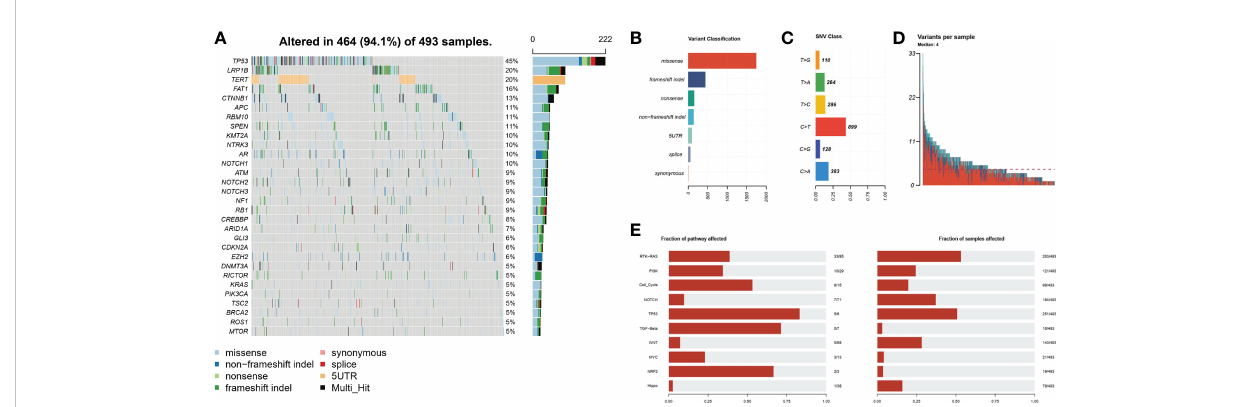
FIGURE 1 Mutational landscape by ctDNA pro fi ling in the Chinese HCC cohort. (A) The ratio of the top 30 genes in the number of mutations. (B) Frequency of different mutation classi fi cations. (C) Frequency of SNV class. (D) Variant number per HCC samples. (E) The number of mutated genes contained in the number of mutated samples per pathway. HCC, hepatocellular carcinoma; SNV, single nucleotide variation.